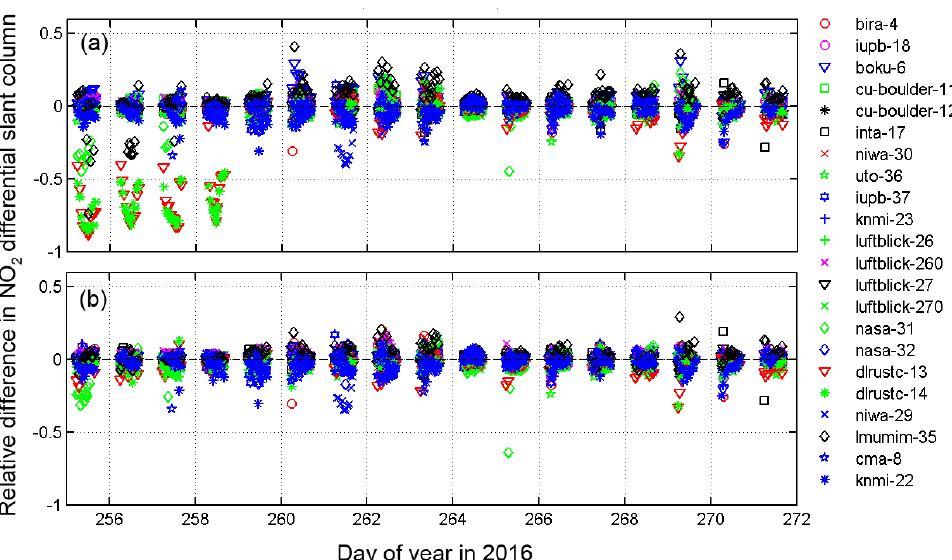
Figure 7. Relative differences of NO 2 dSCDs (in the visible wavelength region) with respect to the median from all instruments measured during the whole semi-blind intercomparison phase for the 287 ◦ azimuthal direction and 1 ◦ elevation angle. (a) Results before correction for elevation offsets; (b) same results after correction for elevation offsets derived from horizon scans. Colours and symbols represent different instruments.